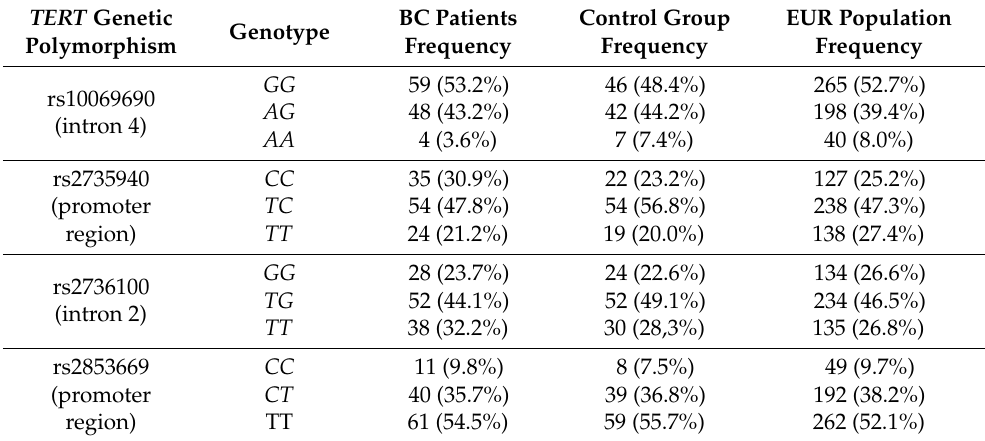
Figure 1. Genomic structure of the human telomerase TERT gene and the location of the studied SNPs and VNTR polymorphism. The exons are shown in grey, while the intronic regions are in white. Table 1. Distribution of TERT genotypes in our group of patients with BC, the control group and the European population.